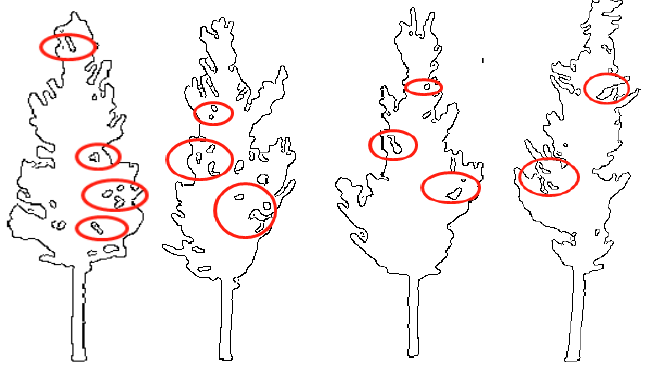
Figure 8. False edges inevitably produced by Canny algorithm.